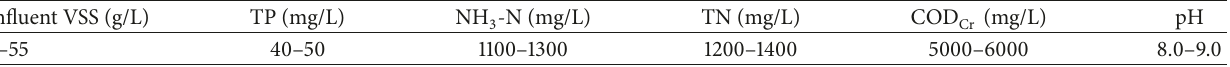
Table 1: Compositions of the piggery wastewater.